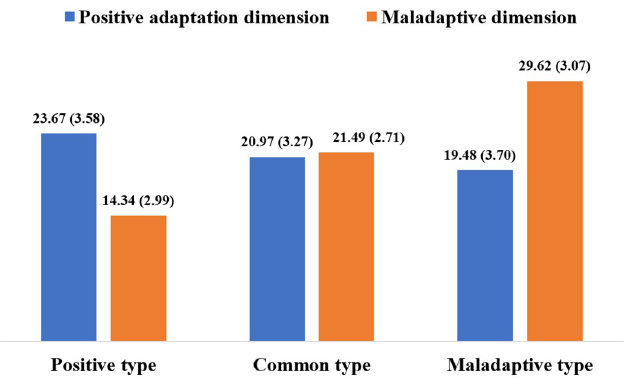
Fig 2. Average score of positive adaptation dimension and maladaptive dimension scores by latent type.